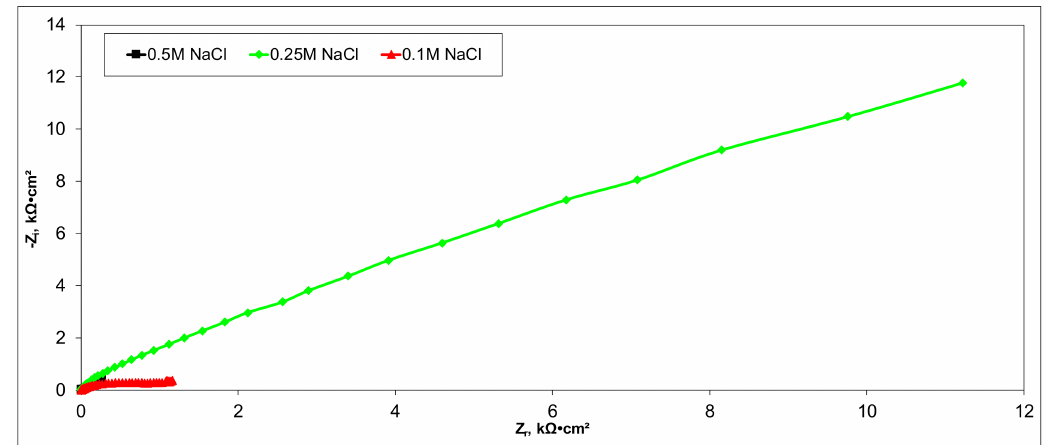
Figure 16. Nyquist plots for the X4 variant in NaCl: 0.5M, 0.25M, 0.1M.